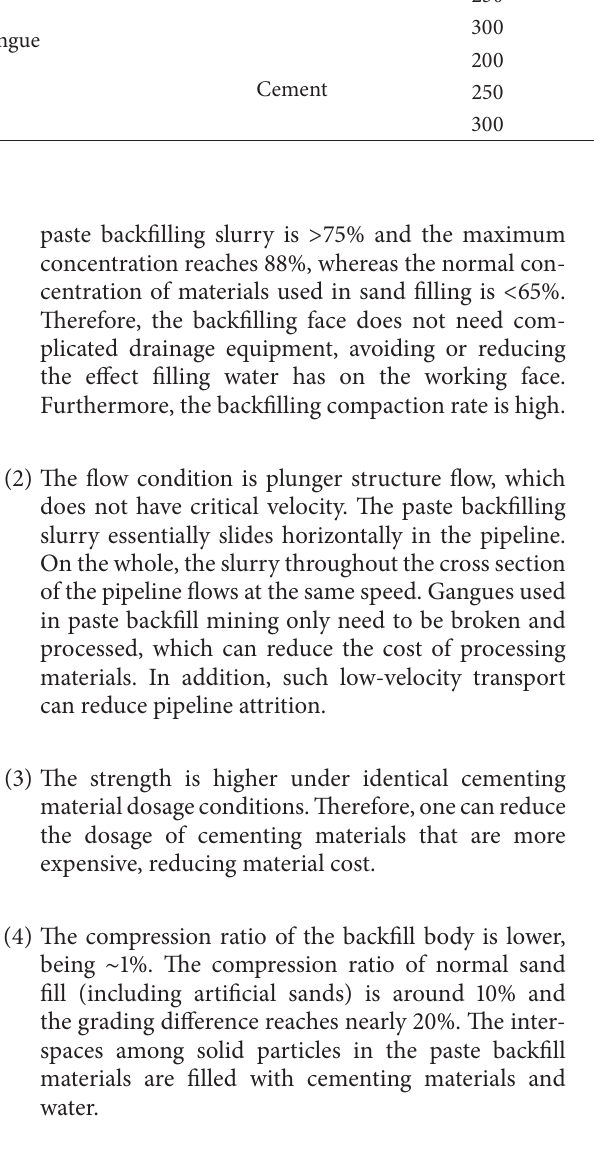
Fine sand from Si